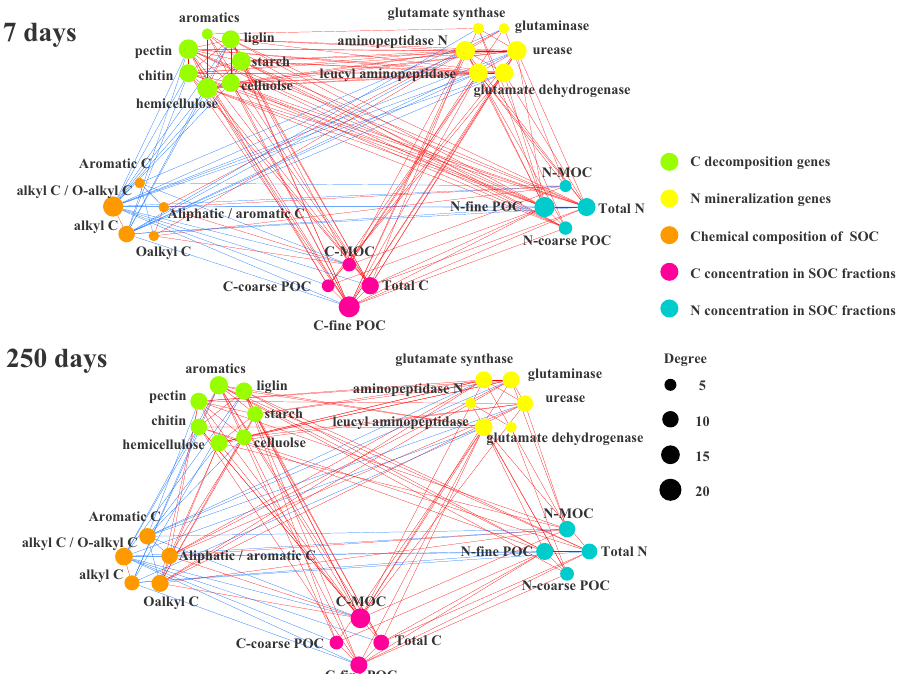
Fig. 5 An overview of networks distributed by C-decomposition genes, N-mineralization genes, soil organic C (SOC) composition, C and N concentrations in SOC fractions after 7 and 250 days of incubation. The red lines indicate positive correlations between two individual nodes, whereas blue lines indicate negative correlations. The size of each node is proportional to the degree between two individual nodes. Total C, total N, C-coarse-POC, C- fi ne-POC, C-MOC, N-coarse-POC, N- fi ne-POC and N-MOC represent total C and N concentrations in soil, C and N concentrations in coarse-POC, fi ne-POC and MOC fractions,